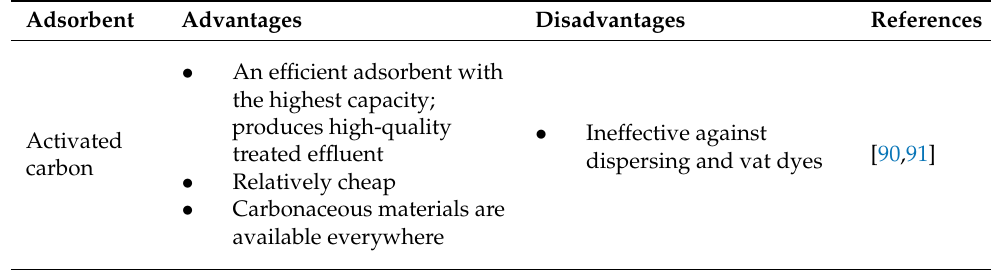
Table 3. Advantages and disadvantages of different